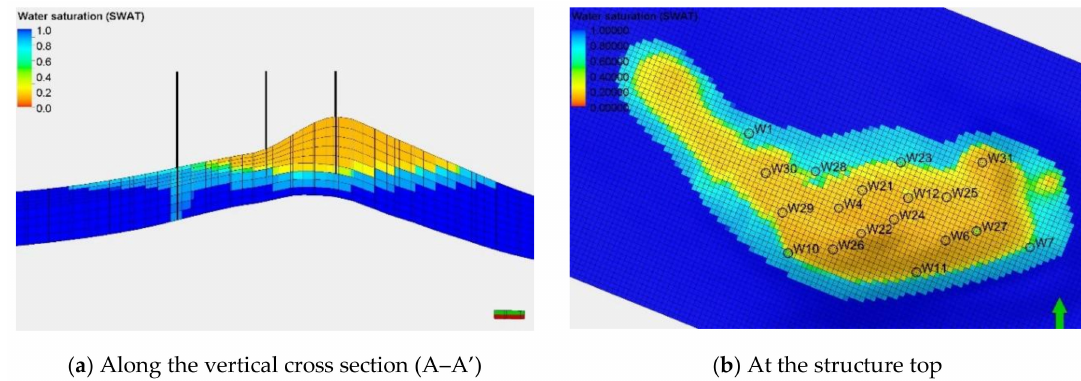
Figure 32. Distribution of brine saturation in 2019.